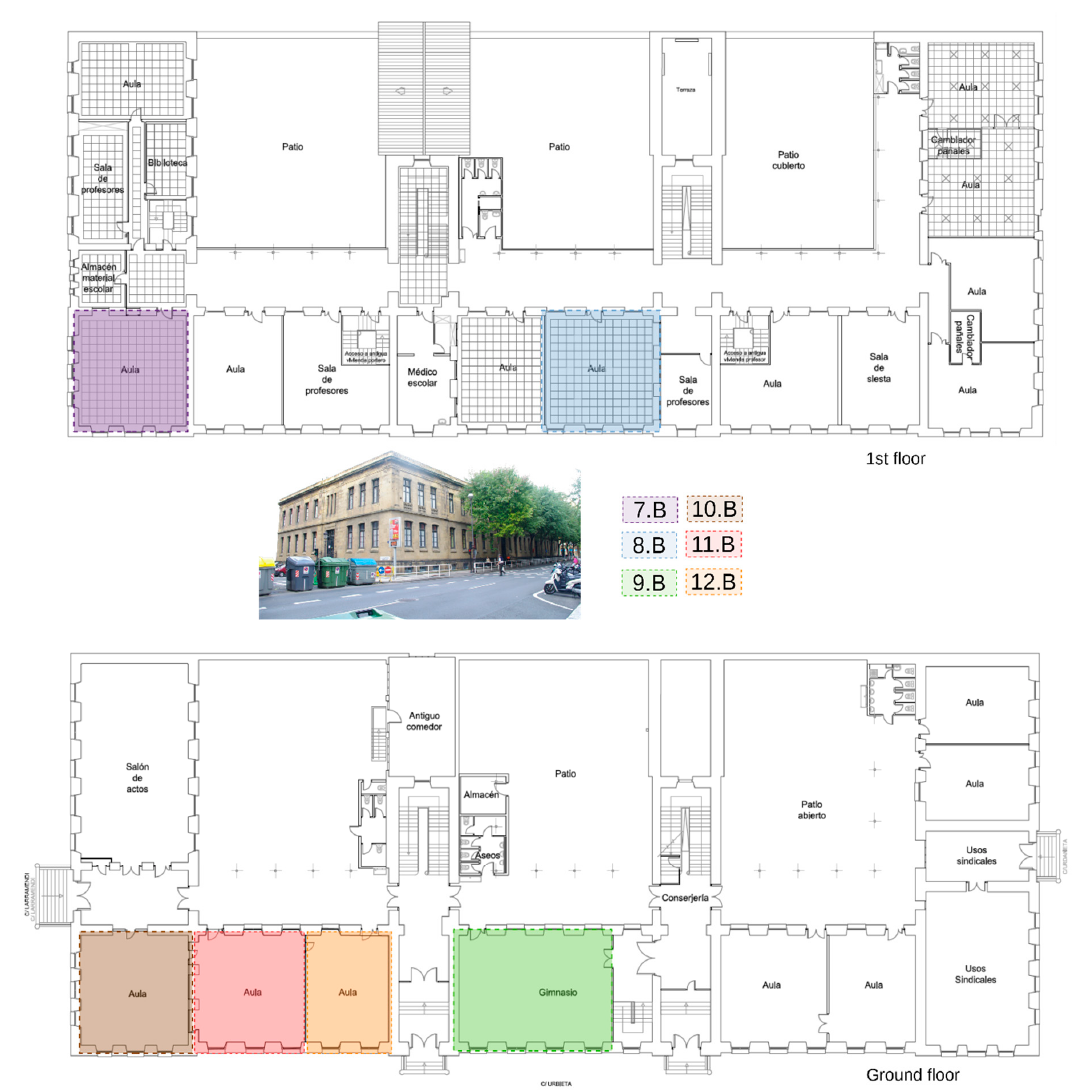
Figure A2. Floor plans of the blower door tests performed in the Urbieta School case study.